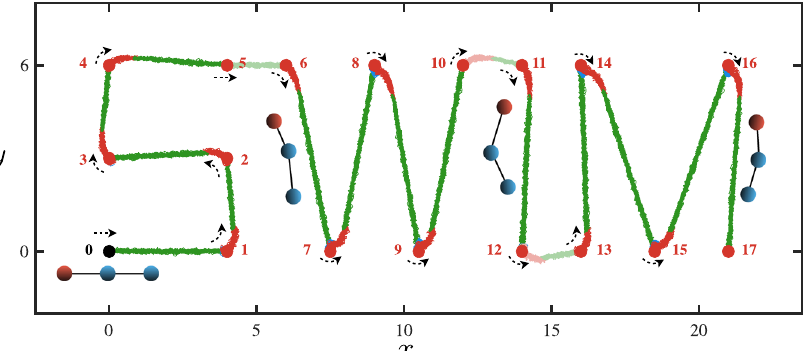
Fig. 5 Demonstration of complex navigation capability of Arti fi cial Intelligence powered swimmer. The Arti fi cial Intelligence powered swimmer switches between various locomotory gaits autonomously in tracing a complex trajectory “ SWIM". The trajectory of the central sphere of the swimmer is colored based on the mode locomotory gaits: steering (blue), transition (red), and translation (green). The swimmer is given a lists of target points (1 – 17) with one target point at a time. The black arrows at each point indicate the intended direction of the swimmer. From the current target point, the swimmer determines the target direction for the next action step t + 1, θ T and adapts the locomotory gaits based on its AI in navigating towards that direction. t þ 1 Schematics of the swimmer con fi gurations (not-to-scale) are shown for illustrative purposes, where the leftmost sphere is marked as red and other two spheres are marked as blue to indicate the swimmer's current orientation. An animation of this simulation is shown in Supplemental Movie